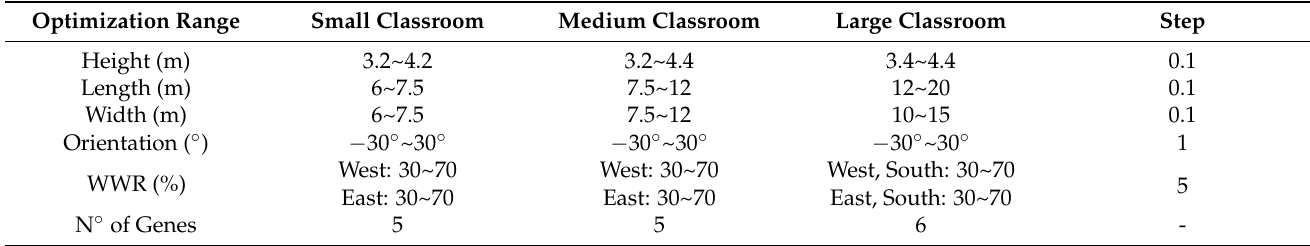
Table 6. Optimized gene targets selection and step size